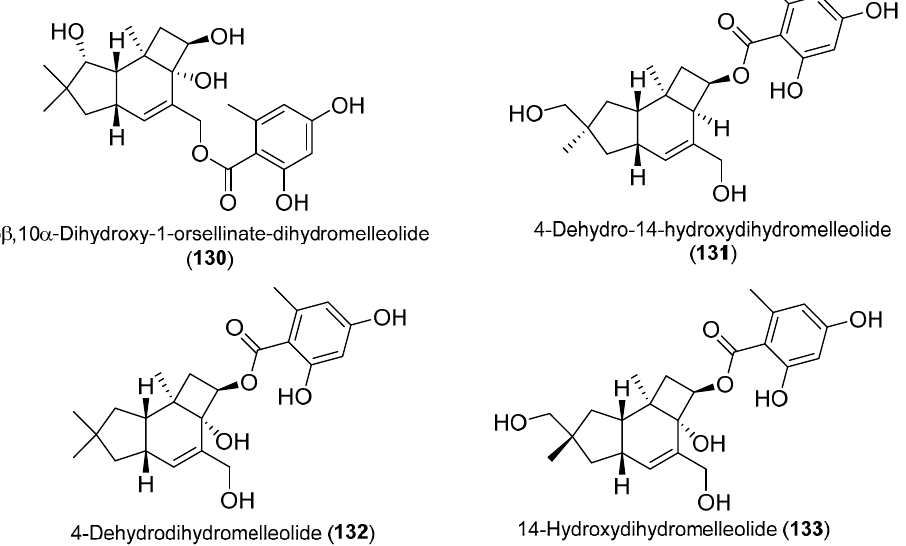
Figure 20. Structures of melleolides 130 – 133 isolated from Armillaria tabescens.